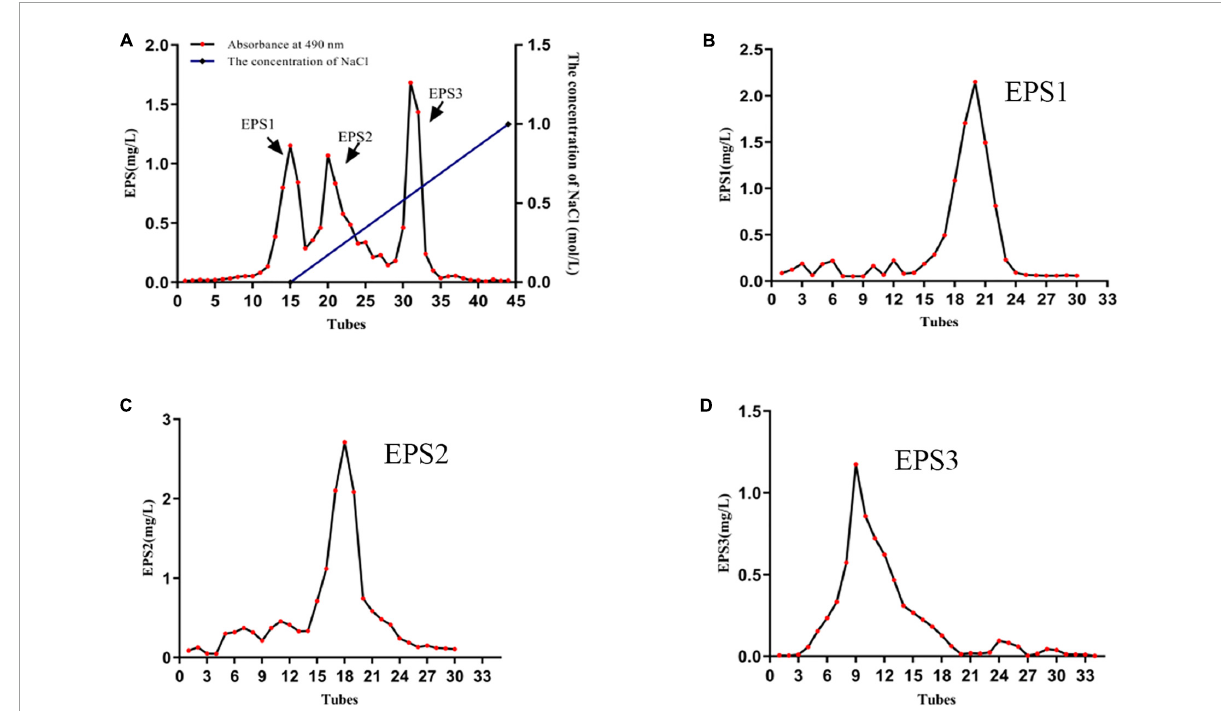
FIGURE2 The characterization of EPSs. (A) Elution profile of EPSs produced by strain L. pantheris TCP102 on DEAE-Sepharose fast flow column. Elution profiles of (B) EPS1, (C) EPS2, and (D) EPS3 on Sepharose CL-6B gel